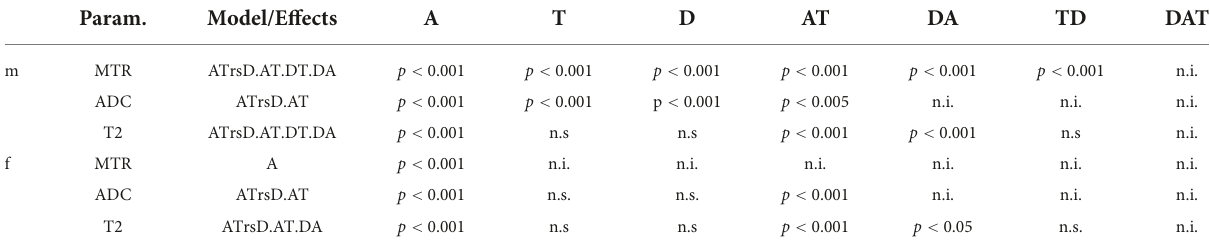
TABLE 1 Selected “best model” and results of the Anova Type III tests of the predictor variables on log-transformed MTR, ADC and T2 data of male (m) (top) and female (f) (bottom) mice. Param.